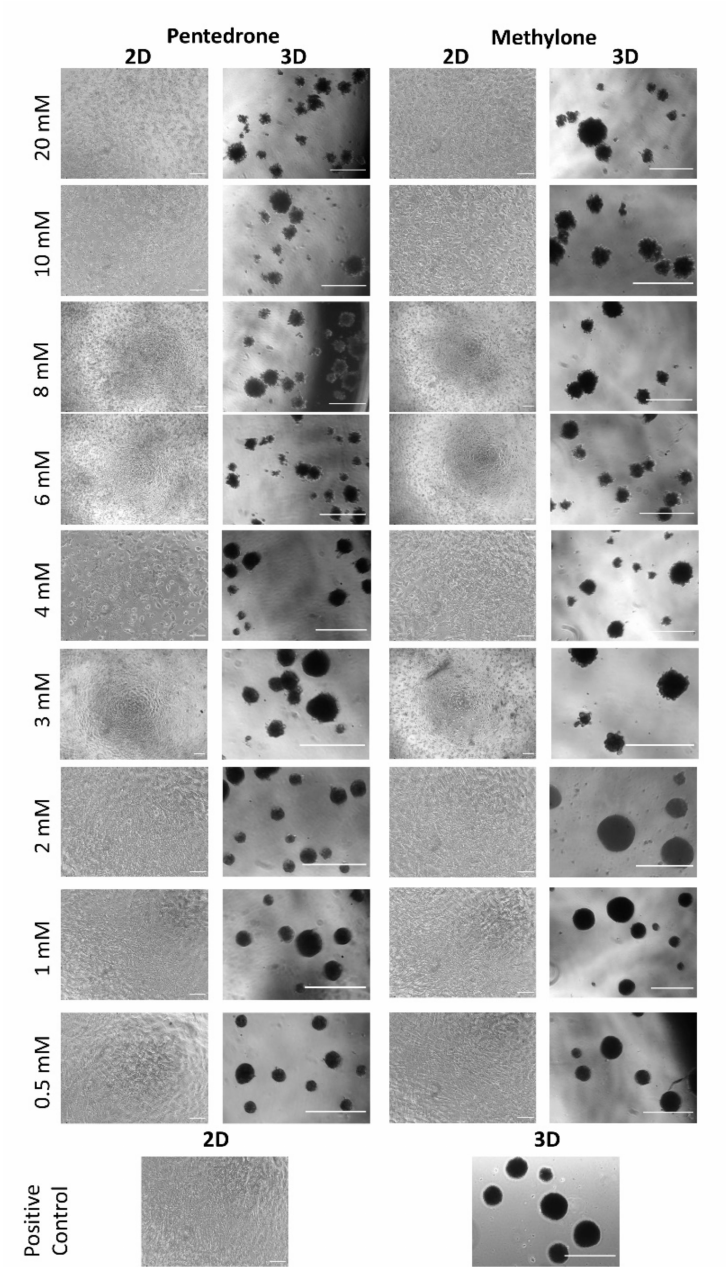
Figure 4. Representative images of HLCs’ morphology in 2D (scale bar = 100 µ m) and 3D (scale bar = 200 µ m) cultures exposed and nonexposed (positive controls) to pentedrone and methylone